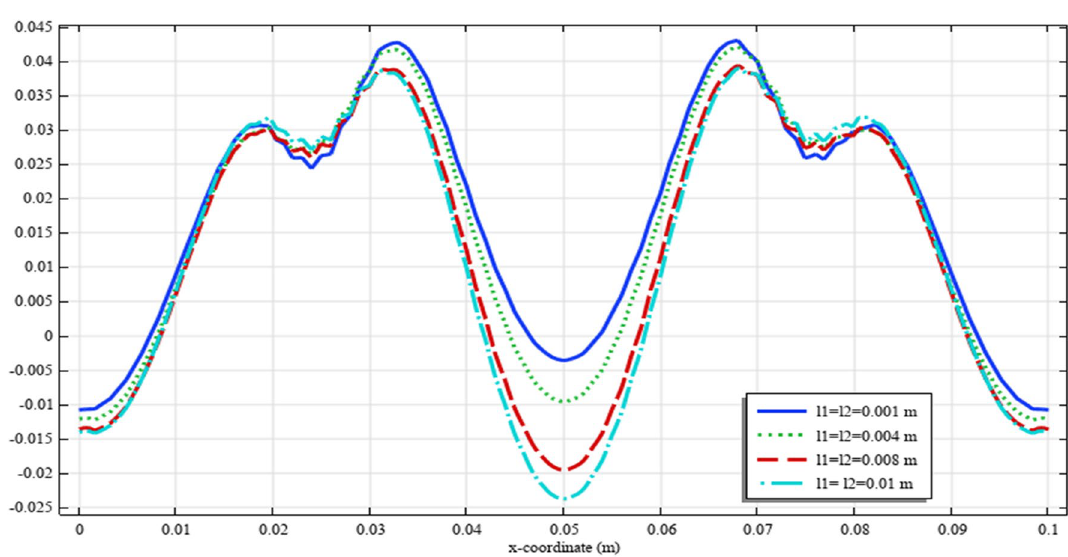
Figure 20. The micro-strain s xx ( x , b / 2 )/ s 0 for different values of ℓ 1 and ℓ 2 (COMSOL